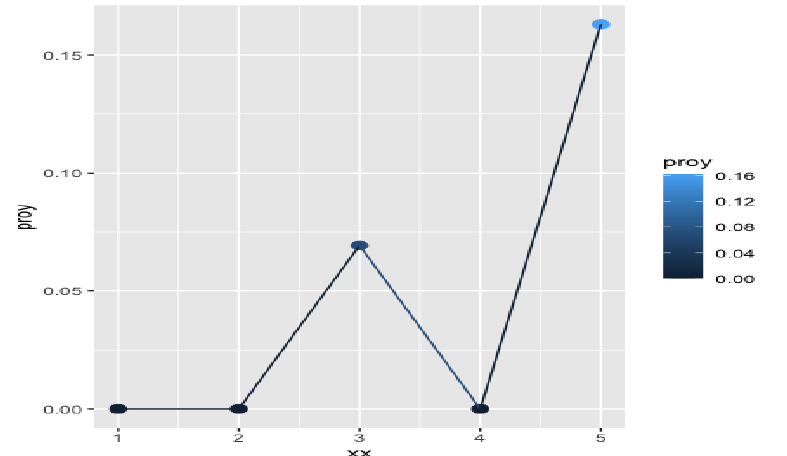
Figure 7. Representation of the projection of the object “cabinet” on the universe U = {“sustainable”, “environment”, “wood”, “waste”, “furniture”